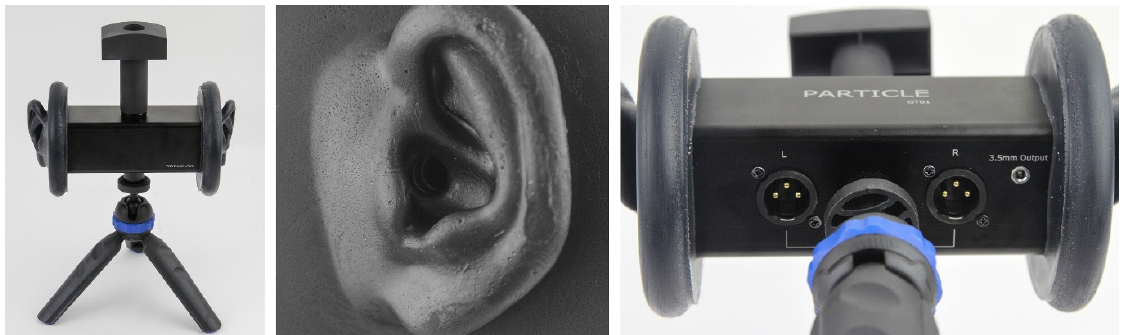
Figure 2. Custom set of artificial ears manufactured with soft silicone earmolds on either side and two IEC711 occluded ear simulators to measure the frequency response of headphones. There are both XLR and 3.5 mm microphone outputs to aid in the same.